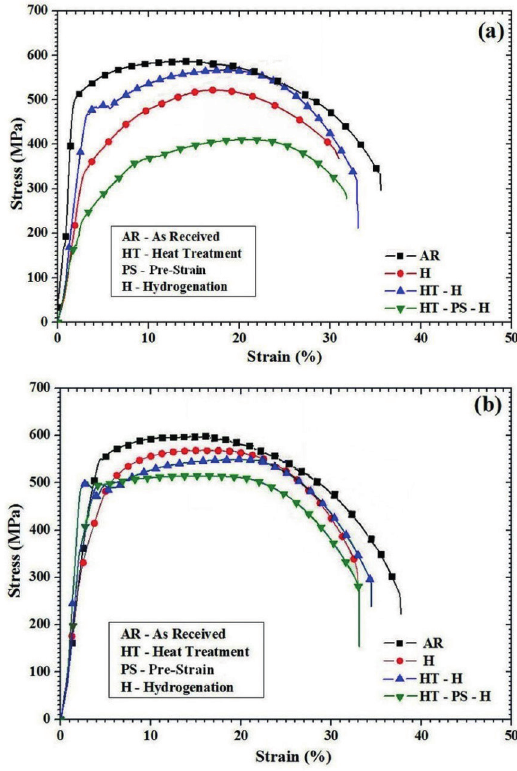
Figure 8: Stress-strain curves for the specimens subjected to different treatments. a) BM, b) FZ.